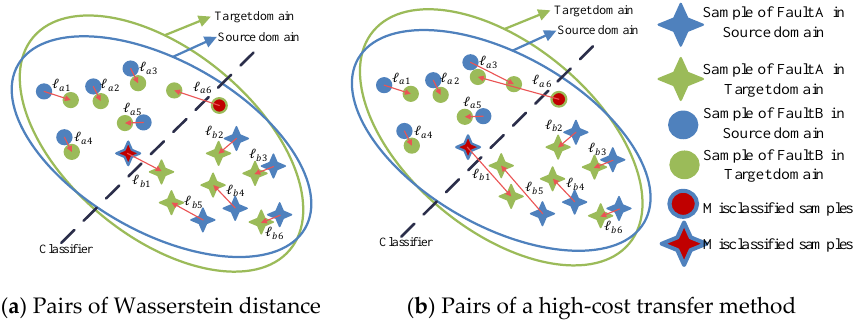
Figure 1. Different pairs for measuring discrepancy between two distributions.